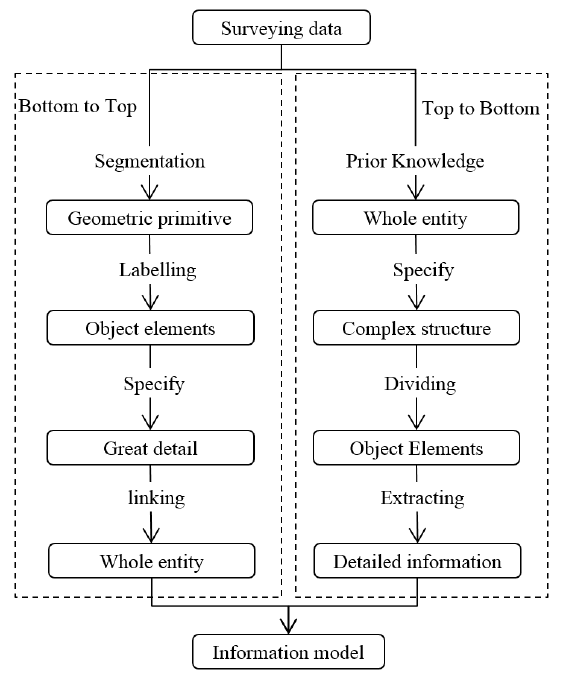
Fig. 3: The processing of Reality-based Historic modelling approach utilizing bottom-to-up and up-to-bottom approach (3) Combination approach in combined libraries